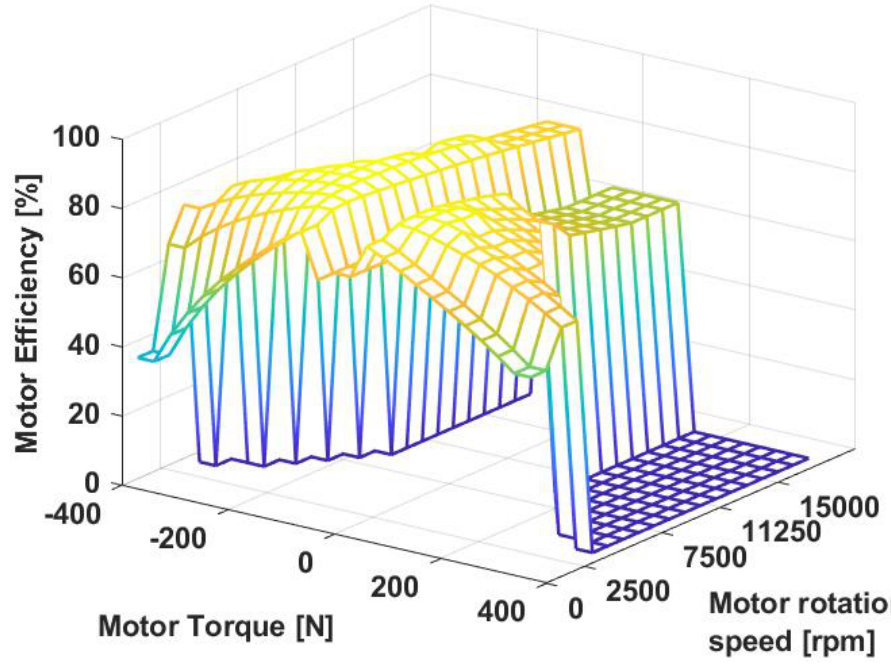
Figure 3. Efficiency map of the reference motor-generator.